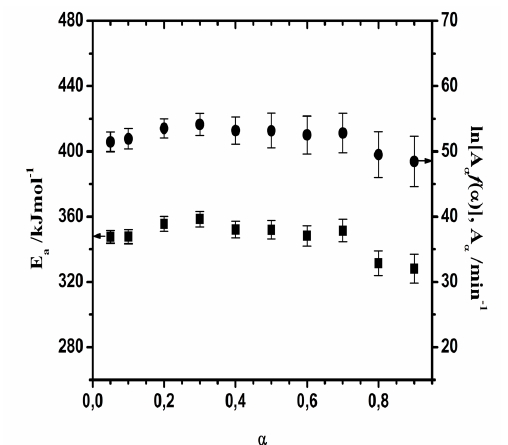
Figure 6 – The apparent activation energy (E a ) (full square symbol) and the apparent intercept (ln[A α f( α )]) (full circle symbol) values calculated by the Friedman method, plotted as a function of the fractional conversion ( α ), for the crystallization process of the amorphous Fe 81 B 13 Si 4 C 2 alloy Slika 6 – Vrednosti prividne energije aktivacije (E a ) (puni kvadratni simboli) i vrednosti prividnih odse č aka (ln[A α f( α )]) (puni kružni simboli) izra č unati Fridmanovom metodom, a predstavljeni u funkciji konverzione frakcije ( α ), za proces kristalizacije amorfne Fe 81 B 13 Si 4 C 2